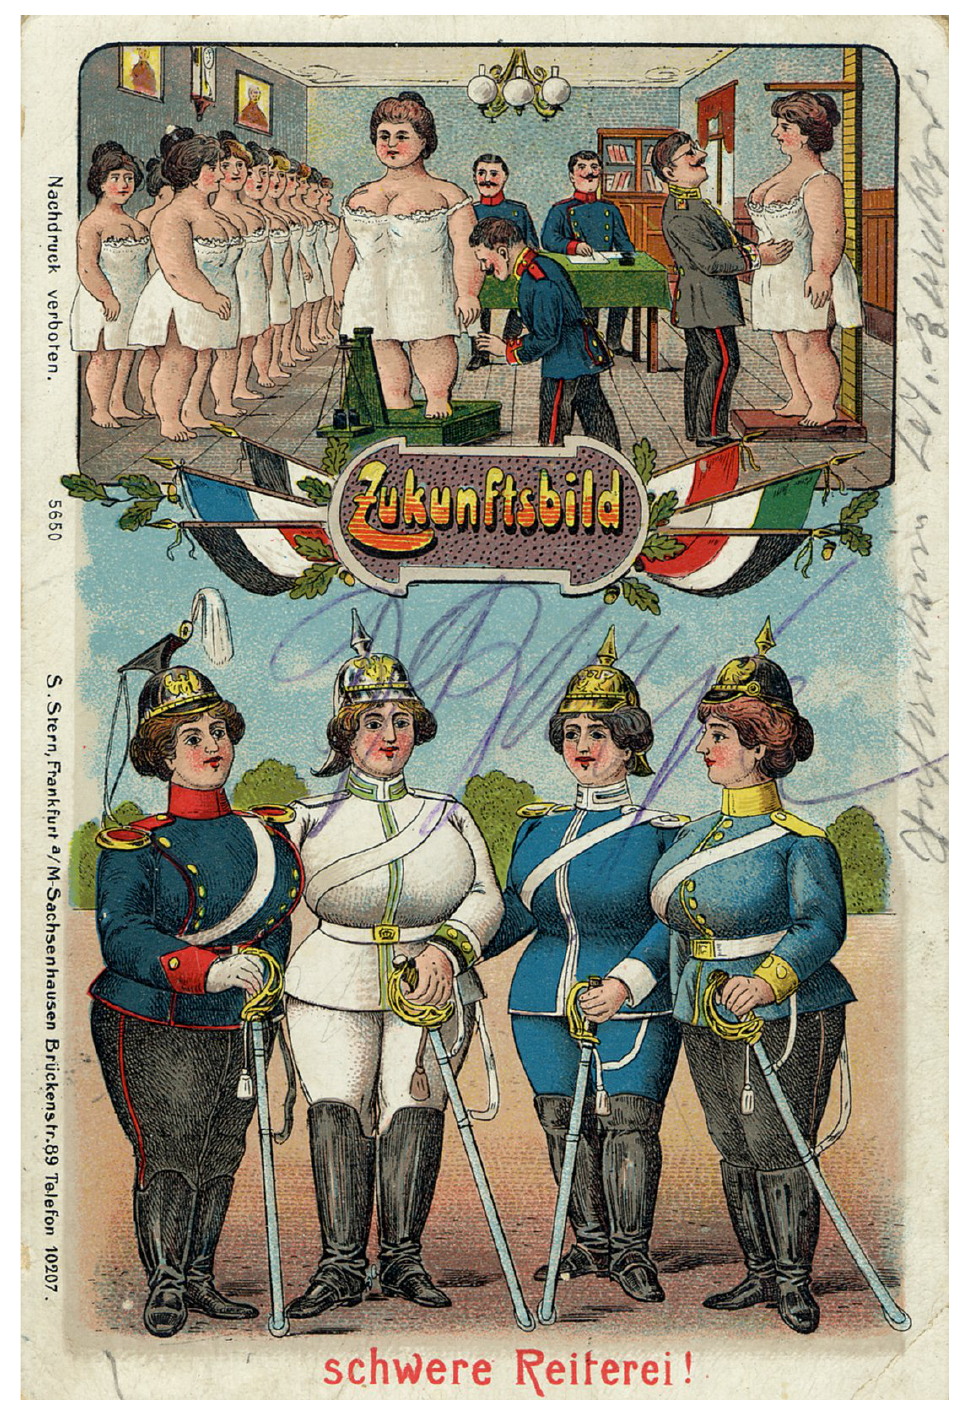
Stiftung Historische Museen Hamburg-Altonaer Museum. 13.8 x 9